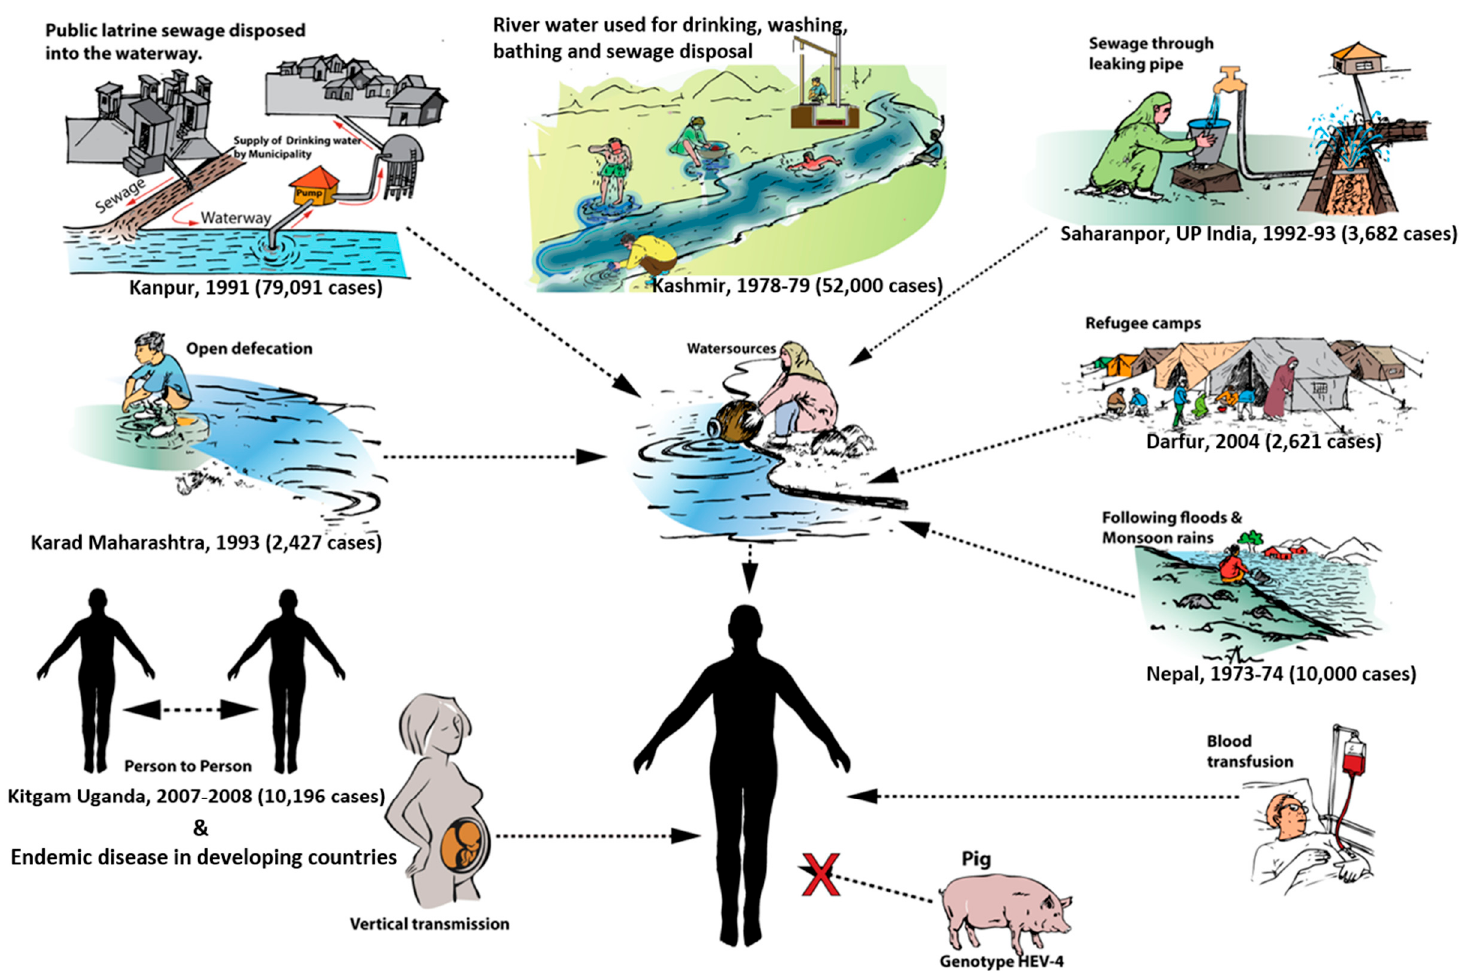
Figure 2. Modes of transmission of hepatitis E in developing countries. The settings for contamination of drinking water have been drawn in sketches, with epidemics reported in each case.